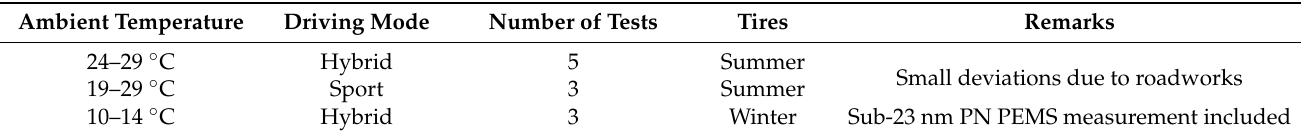
Table 3. Summary of the performed test